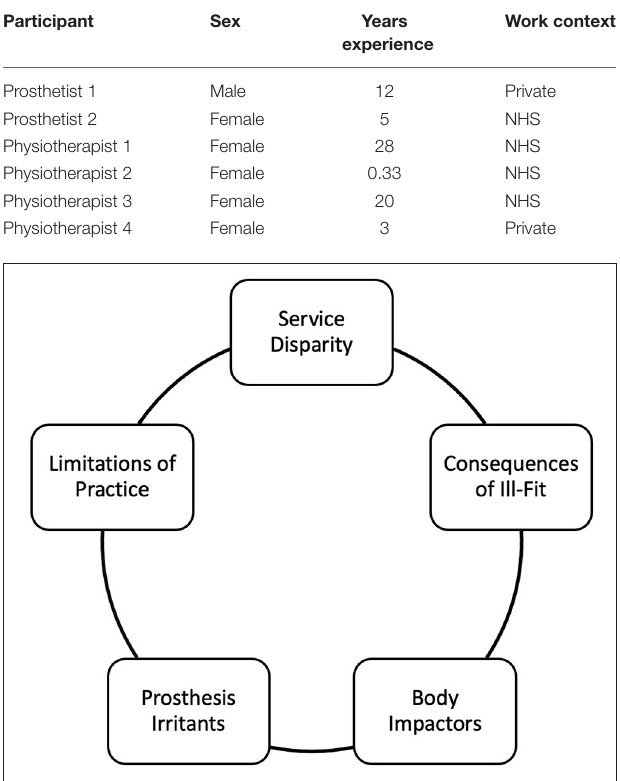
FIGURE 1 | Themes identified from interviewee